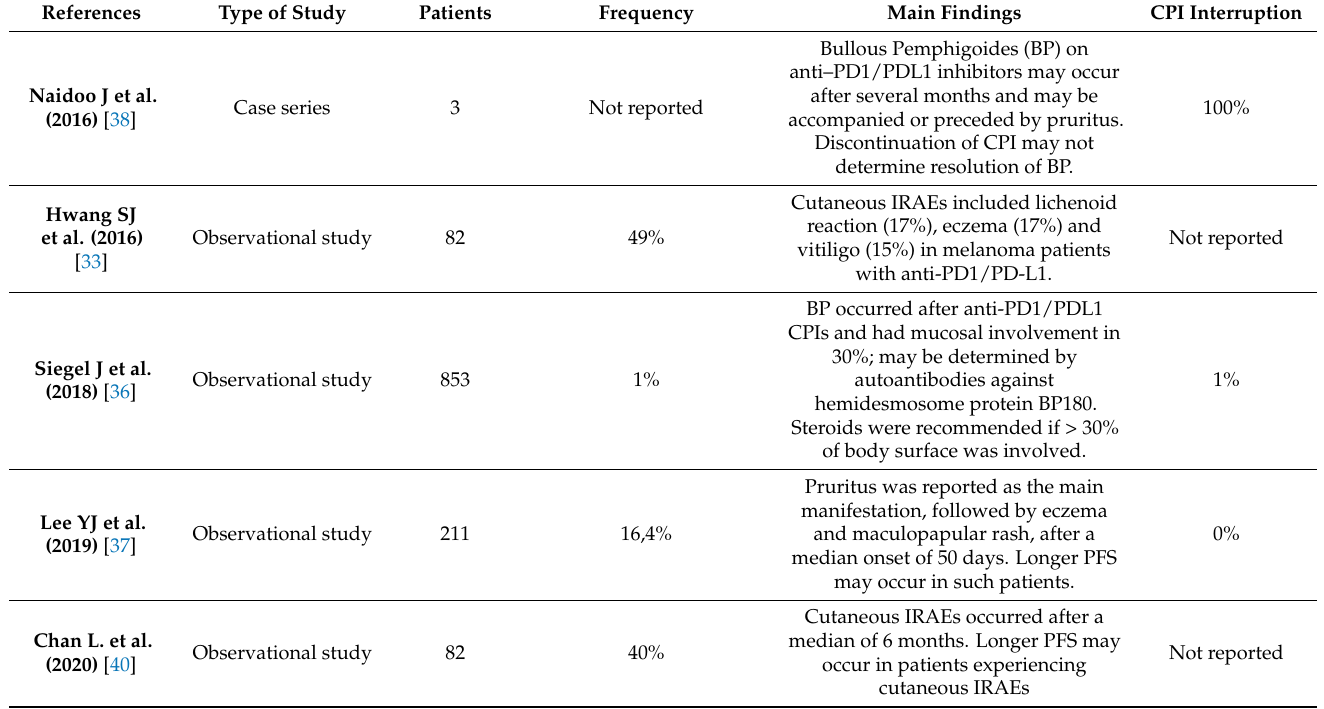
Table 3. Cutaneous immune-related adverse events after checkpoint inhibitors